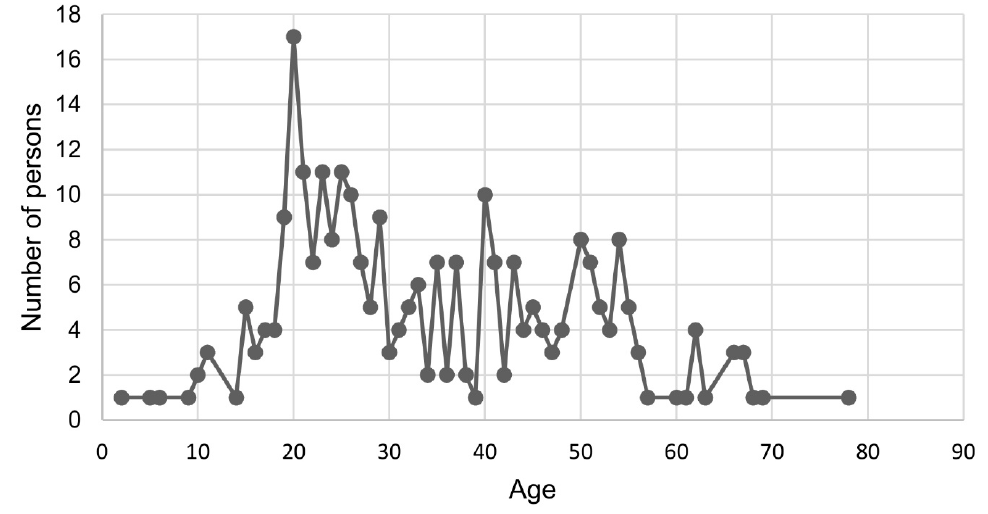
Figure A1. Age distribution for persons with severe and slighter injuries from wild boar-vehicle accidents 2003–2016 in Sweden.